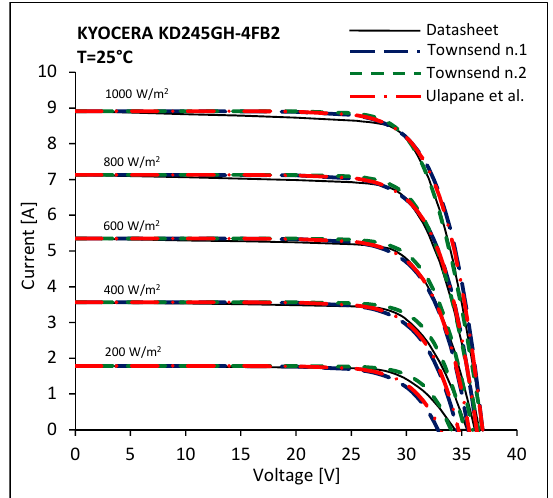
Figure 5. Comparison between the issued I-V characteristics of the Kyocera KD245GH-4FB2 at T = 25 °C and the characteristics calculated by means of the Townsend n.1, the Townsend n.2 and the Ulapane et al. models.